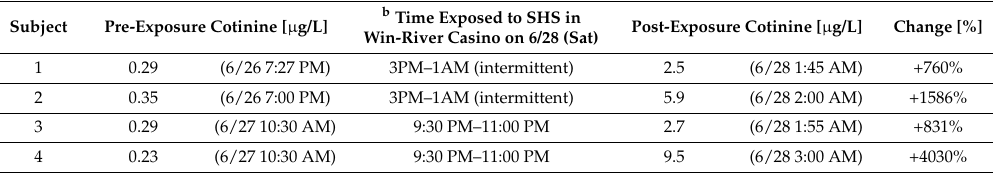
Table S2. Urinary cotinine levels in four visitors before and after exposure to secondhand tobacco smoke in the Win-River Casino on a Saturday in 2008 a .